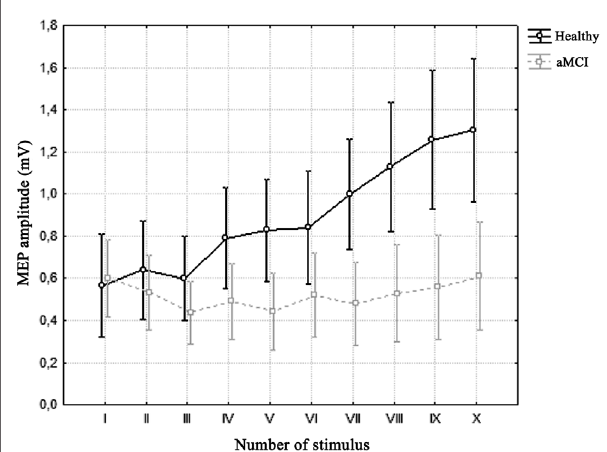
FigUre 2 | average motor-evoked potential (MeP) amplitude across trains of 5 hz-rTMs in the two groups. Vertical bars denote 0.95 confidence intervals. Repeated measures ANOVA showed a significant interaction of factors “Number of Stimulus” ( x -axis) and “Group” (healthy vs. aMCI). Bonferroni’s correction revealed that while there was no significant difference across stimuli in the MCI group, there was a significant increase in MEP amplitude in healthy controls from the seventh stimulus onward.